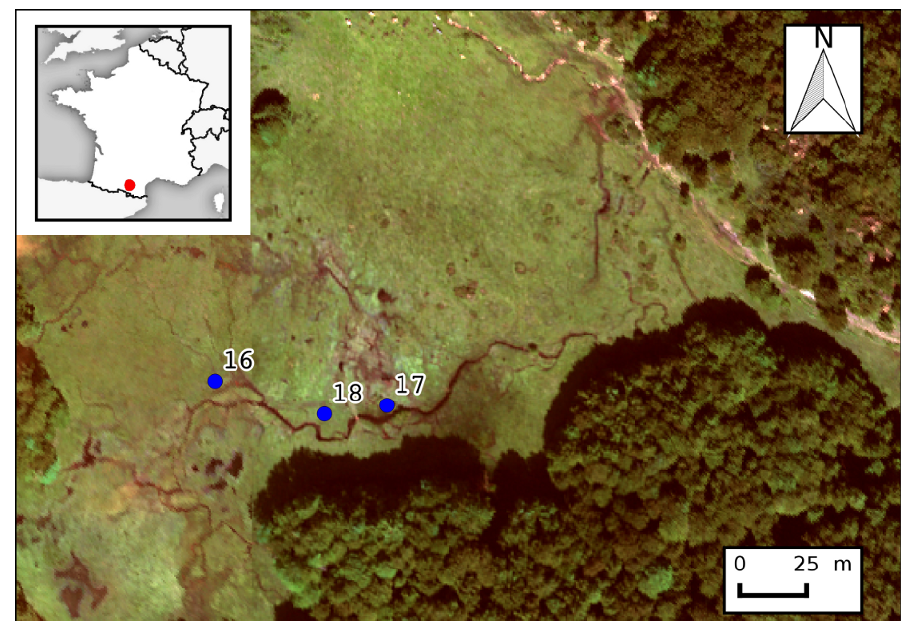
Figure A15. Location of the in situ spectroradiometer measurements for the plots of Salix sp.